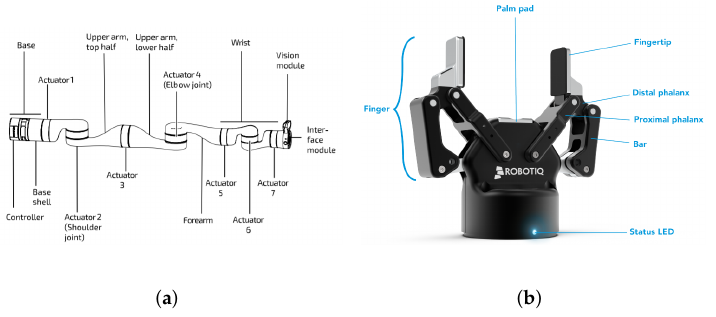
Figure 2. The models of the robotic arm and gripper composing the grasping system. ( a ) The kinematic model of KINOVA Gen3; ( b ) the kinematic model of Robotiq